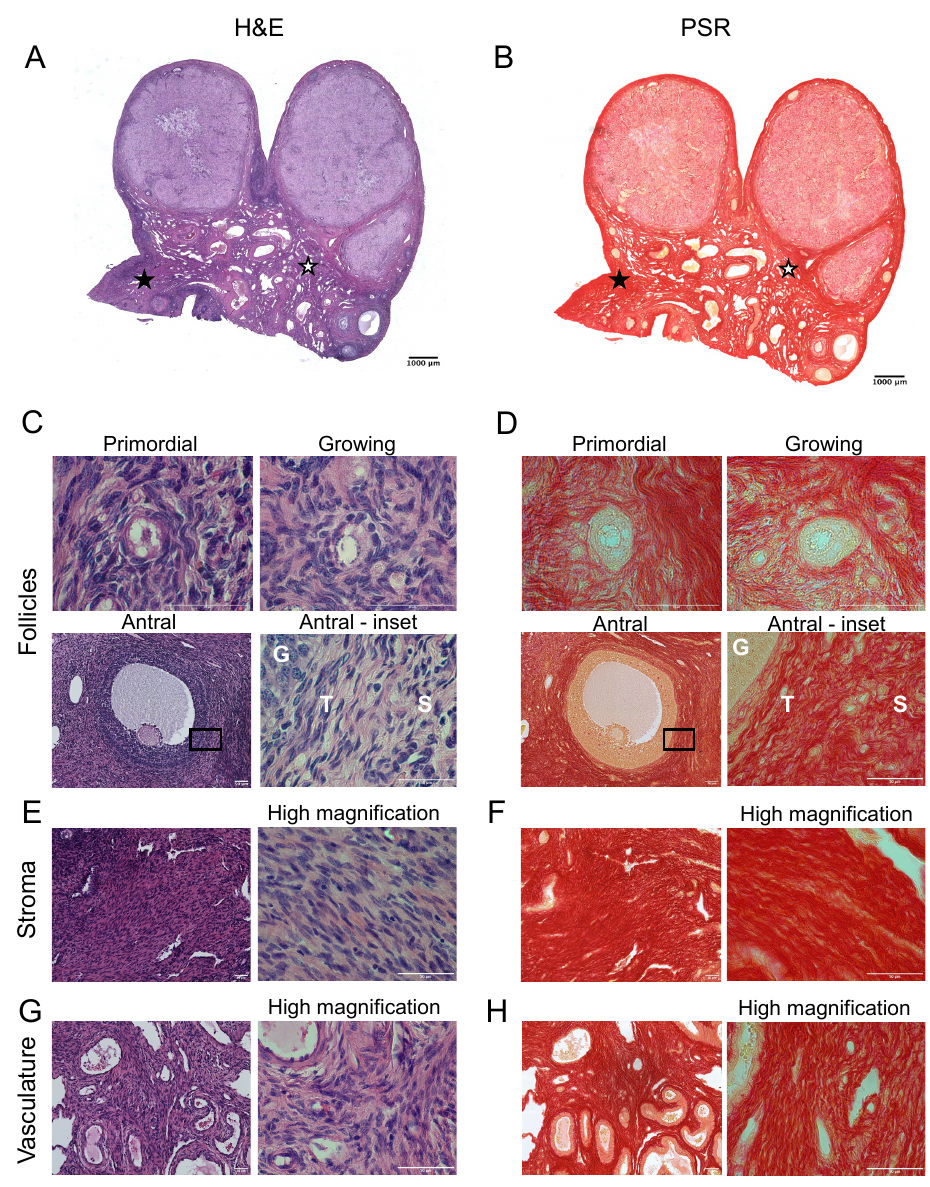
Figure 2. Picrosirius red staining detects collagen in porcine ovarian follicles, stroma, and vasculature. Hematoxylin and eosin (H&E) staining ( left ) and picrosirius red (PSR) staining of porcine ovarian tissue sections ( right ). ( A ) H&E staining illustrates the microanatomical structure of a porcine ovarian tissue section. ( B ) PSR staining localizes collagen (red) in a section sequential to that of the one seen in ( A ). H&E and PSR staining in ( C , D ) primordial follicle, growing follicle, and antral follicle (note that the antral follicle image was taken from a different porcine tissue section than shown in ( A , B ), ( E , F ) stroma, ( G , H ) vasculature, respectively. The area demarcated by the black rectangles in low magnification images ( C , D —antral) is shown in higher magnification images to the right. High magnification images of stroma ( E , F ) and vasculature ( G , H ) are seen to the right of each low magnification image. G—granulosa cell layer, T—theca cell layer, S—stroma. The scale bars in ( A , B ) are 1000 µ m and in ( C – H ) are 50 µ m. Images are representative of porcine ovaries ( n = 2 pigs, n = 2 ovaries/pig, n = 2 sections/ovary). White stars indicate location of vasculature, while black stars indicate location of the